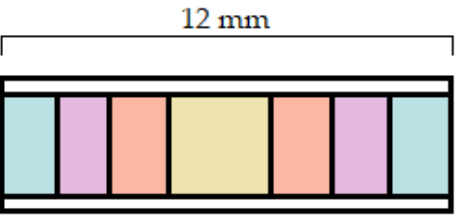
Figure 1. Cross-section of the acetaminophen-containing matrix tablets based on the authors ’ figure. The different colors label dissimilar compartments [30].